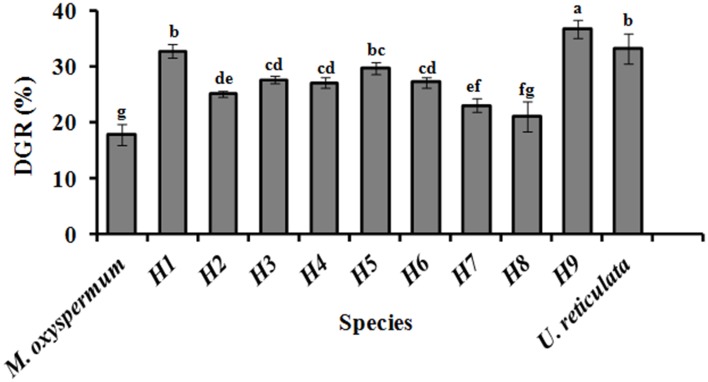
Growth rate (DGR %) of the regenerated hybrids and the fusion partners. H1–9, hybrids. Bars with different letters represent means significantly different from each other at p < 0.05.